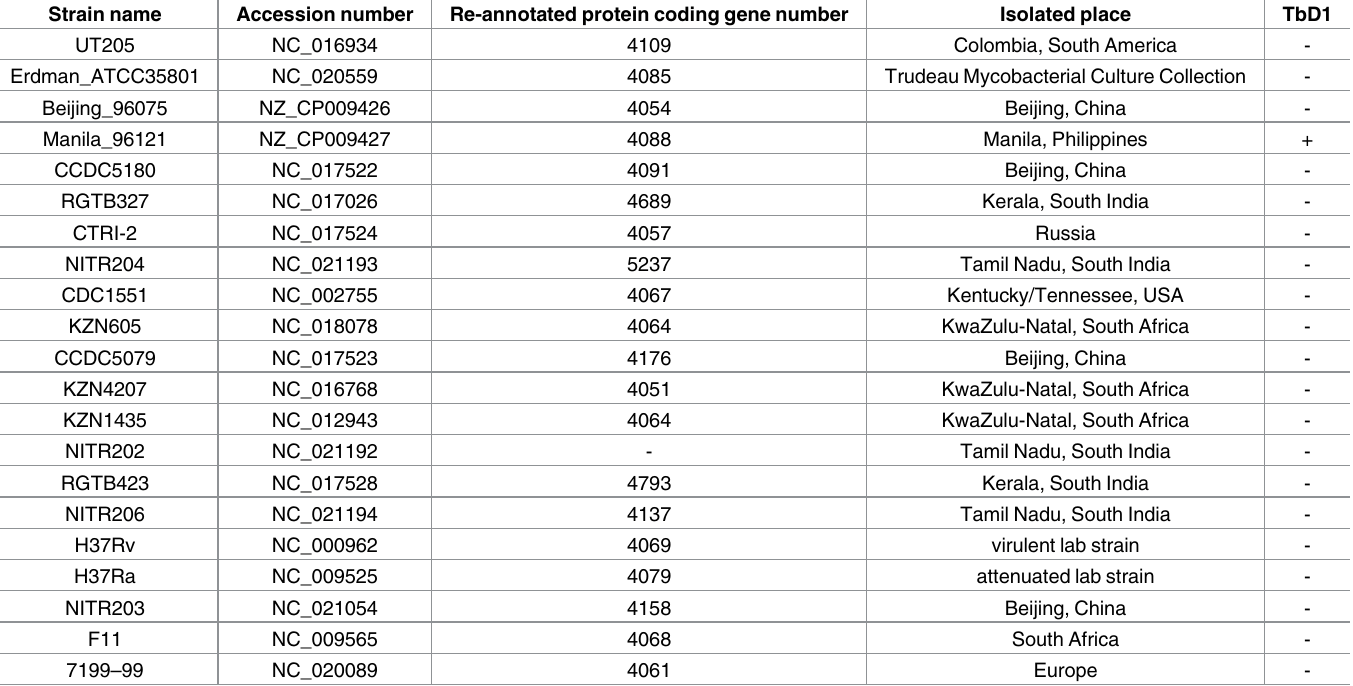
Table 1. Strain information